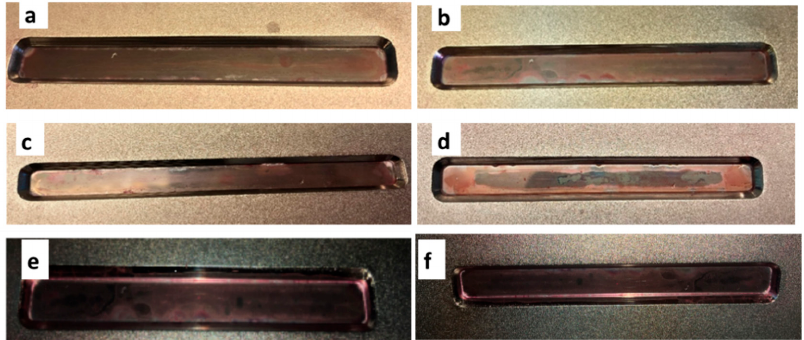
Figure 9. Attenuated total reflectance (ATR) crystal, after the experiment, stained with safranin